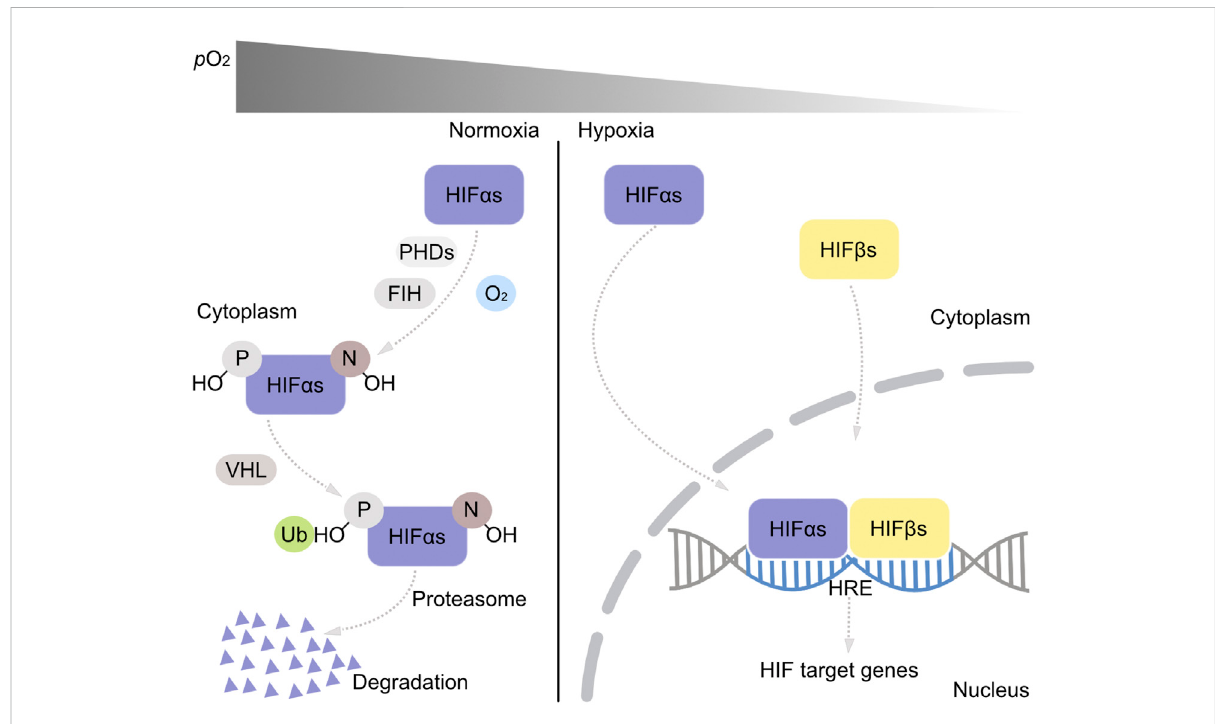
FIGURE 1 TheHIFoxygensensingpathway.Undernormoxicconditions,proline(P)andasparaginyl(N)residuesinHIF α sare fi rstrecognizedanddegraded by activated prolyl hydroxylases (PHDs) and asparaginyl hydroxylase (FIH). The hydroxylated proline residues (P-OH) bind on HIF α s and are ubiquitinated by the VHL and degraded by proteasomes within the cytoplasm. Under hypoxia, PHDs and FIH are inactivated and HIF α s are transported into the nucleus and form heterodimers with HIF β s. This heterodimer binds on the hypoxia responsive element (HRE) in the DNA structure and functions as a transcription factor activating or repressing the transcription activities of the downstream